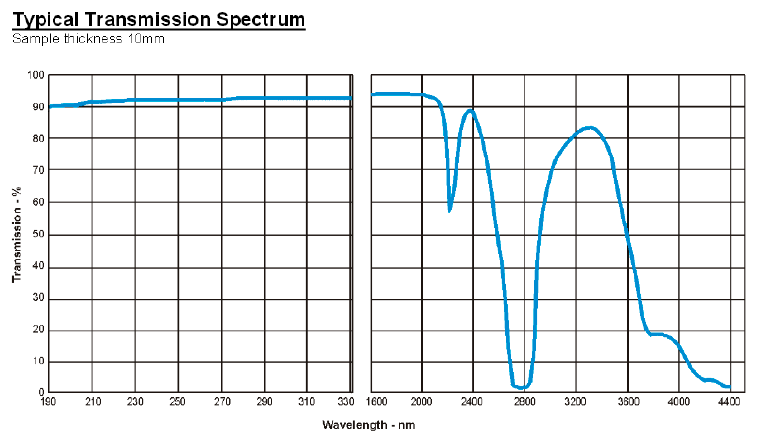
Figure 4. Transmission spectrum of fused silica window material [15].